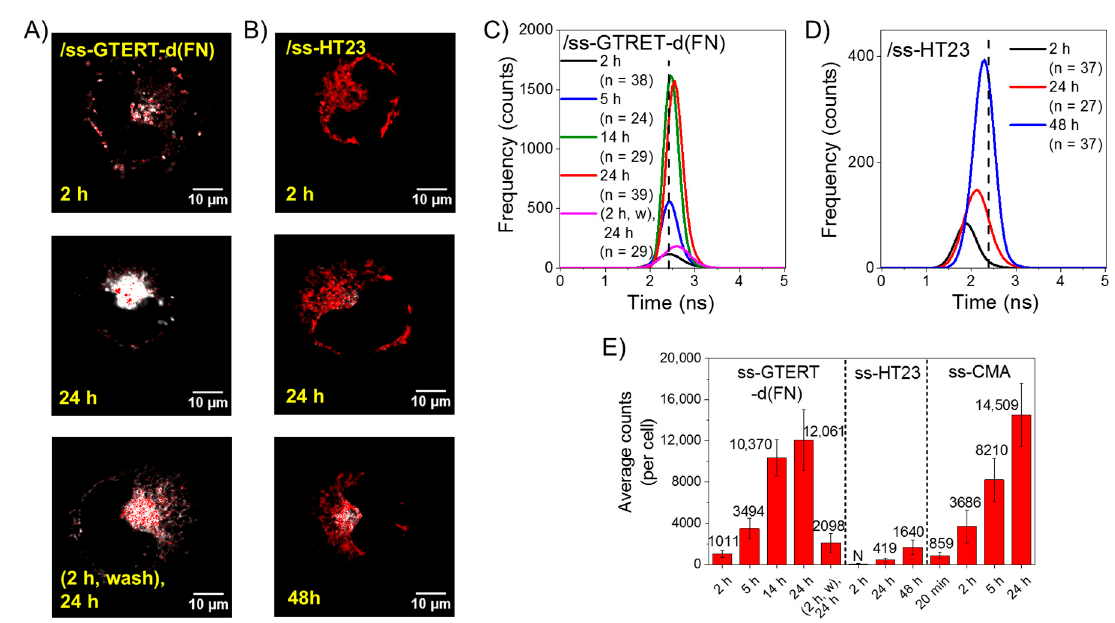
Figure 4. Time-gated FLIM images of exogenous ss-GROs in CL1-0 live cells. Time-gated FLIM images of 5 µ M o -BMVC mixed with 15 µ M ss-GTERT-d(FN) incubated with CL1-0 live cells for 2 h and overnight (( A ), top and middle ). In addition, the samples were washed with PBS twice after the 2 h incubation of 5 µ M o -BMVC and 15 µ M ss-GTERT-d(FN) with CL1-0 live cells and then cultivated in a new medium overnight (( A ), bottom ). The incubation of 5 µ M o -BMVC mixed with 15 µ M ss-HT23 with CL1-0 live cells for 2 h, 24 h, and 48 h ( B ). The corresponding plots of their average photon counts of o -BMVC fluorescence per cell ( C , D ), respectively. The histograms of the average photon counts per cell with a decay time ≥ 2.4 ns after the incubation of ss-GTERT-d(FN), ss-HT23, and ss-CMA with CL1-0 live cells at different times, where N denotes negligible ( E ). We have further examined the time-gated FLIM images of 5 μ M o-BMVC mixed with 15 μ M ss-HT23 after the 2 h, 24 h, and 48 h incubations with CL1-0 live cells (Figure 4B).